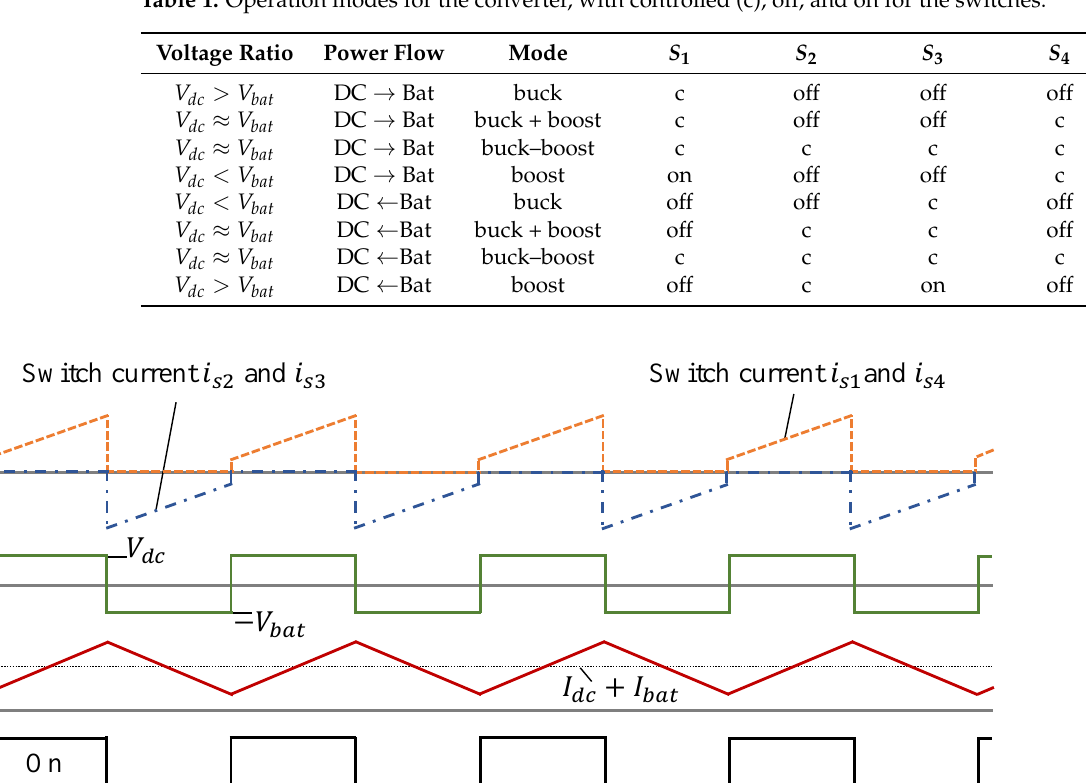
Table 1. Operation modes for the converter, with controlled (c), off, and on for the switches.